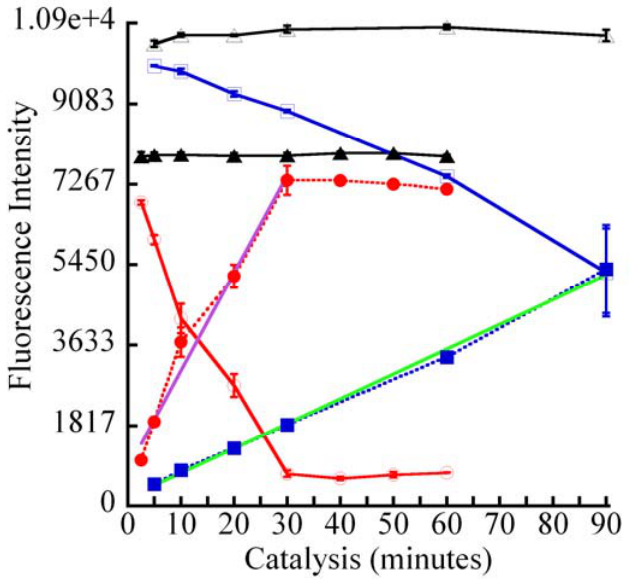
Figure 7. Pseudo -kinetics of laccase- and peroxidase-catalyzed oxidation of CA. Laccase (0.5  g/mL) or peroxidase (0.1  g/mL) was reacted with 250  M CA in 96-well white plates for the indicated duration and then stopped with 250 mM KOH. Fluorescence was measured using  ex of 290, 310 and 340 nm with  em of 416 nm. Due to the nearly identical kinetic profiles, only the data from  ex of 290 nm is shown. The black tracings are “control” fluorescence from unmodified CA during peroxidase (closed triangles) or laccase (open triangles) catalysis. Closed circles (red dotted tracing) represent  RFU from peroxidase oxidized CA with linearity ( r 2 ) between 2.5 and 30 min of 0.978 (solid purple curve fit). Open circles (solid red tracing) are decreasing emission intensities over time following peroxidase catalysis. Open squares connected by the solid blue tracing represent fluorescence decline due to laccase oxidation of CA. Closed squares connected by dotted blue tracing are the upward trajectory of  RFU values from laccase-oxidized CA. Linearity ( r 2 ; solid green tracing) was